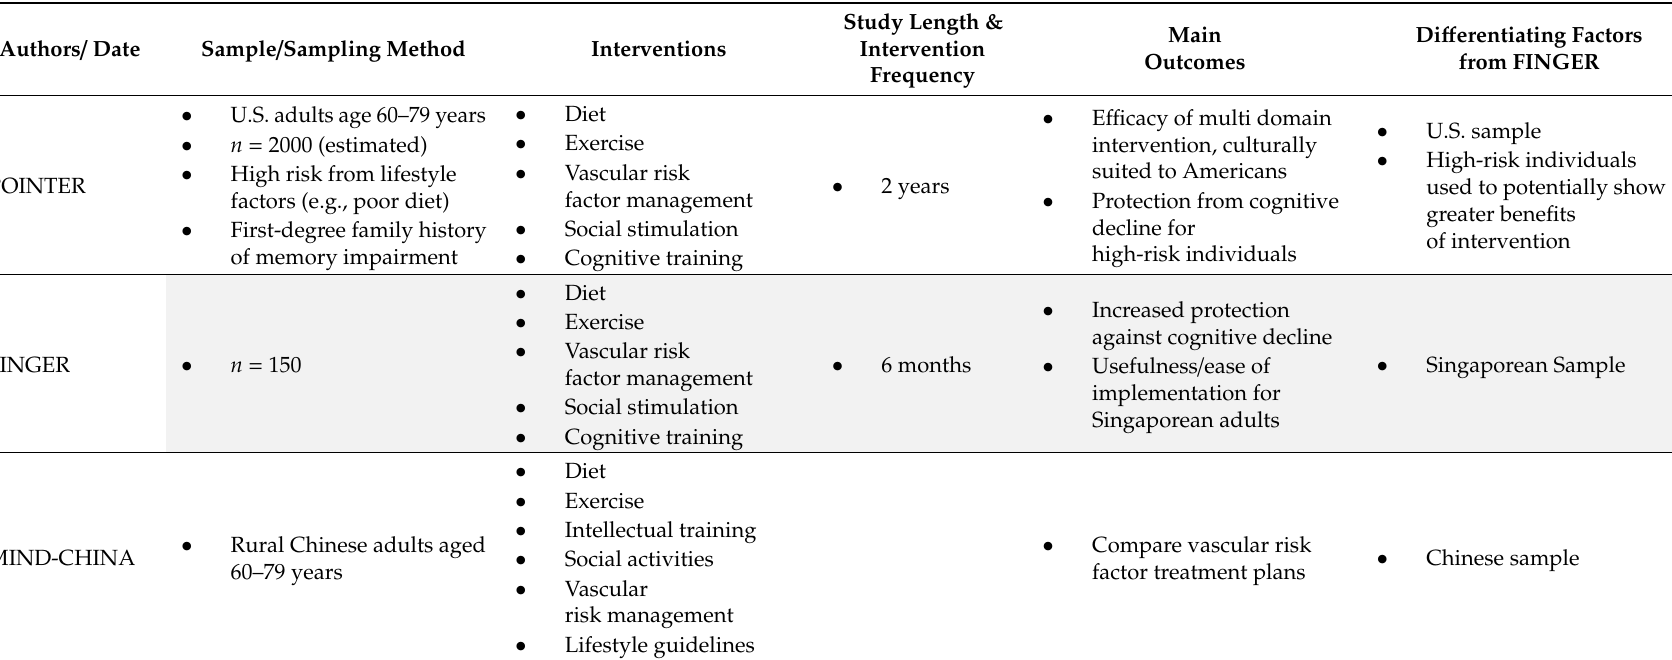
Table 3. On-going and prospective World-Wide Fingers multidomain interventions to enhance cognitive reserve and reduce risk of